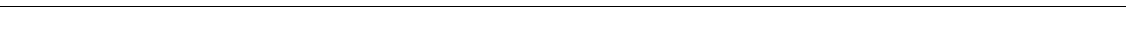
Confocal images of late third instar wing discs stained with anti- b -GAL ( twi-lacZ ), anti-Mef2 antibody and DAPI. Z-stack-projected images of adepithelial area were magnified. Quantification of total number of nuclei in Twi-positive area using DAPI staining, and Twi-positive area relative to total wing area, mean ± s.e.m., n ¼ 14, 10 wing discs per genotype, t -test with Welch’s correction, P 4 0.01. Two independent experiments. ( b ) The expression of